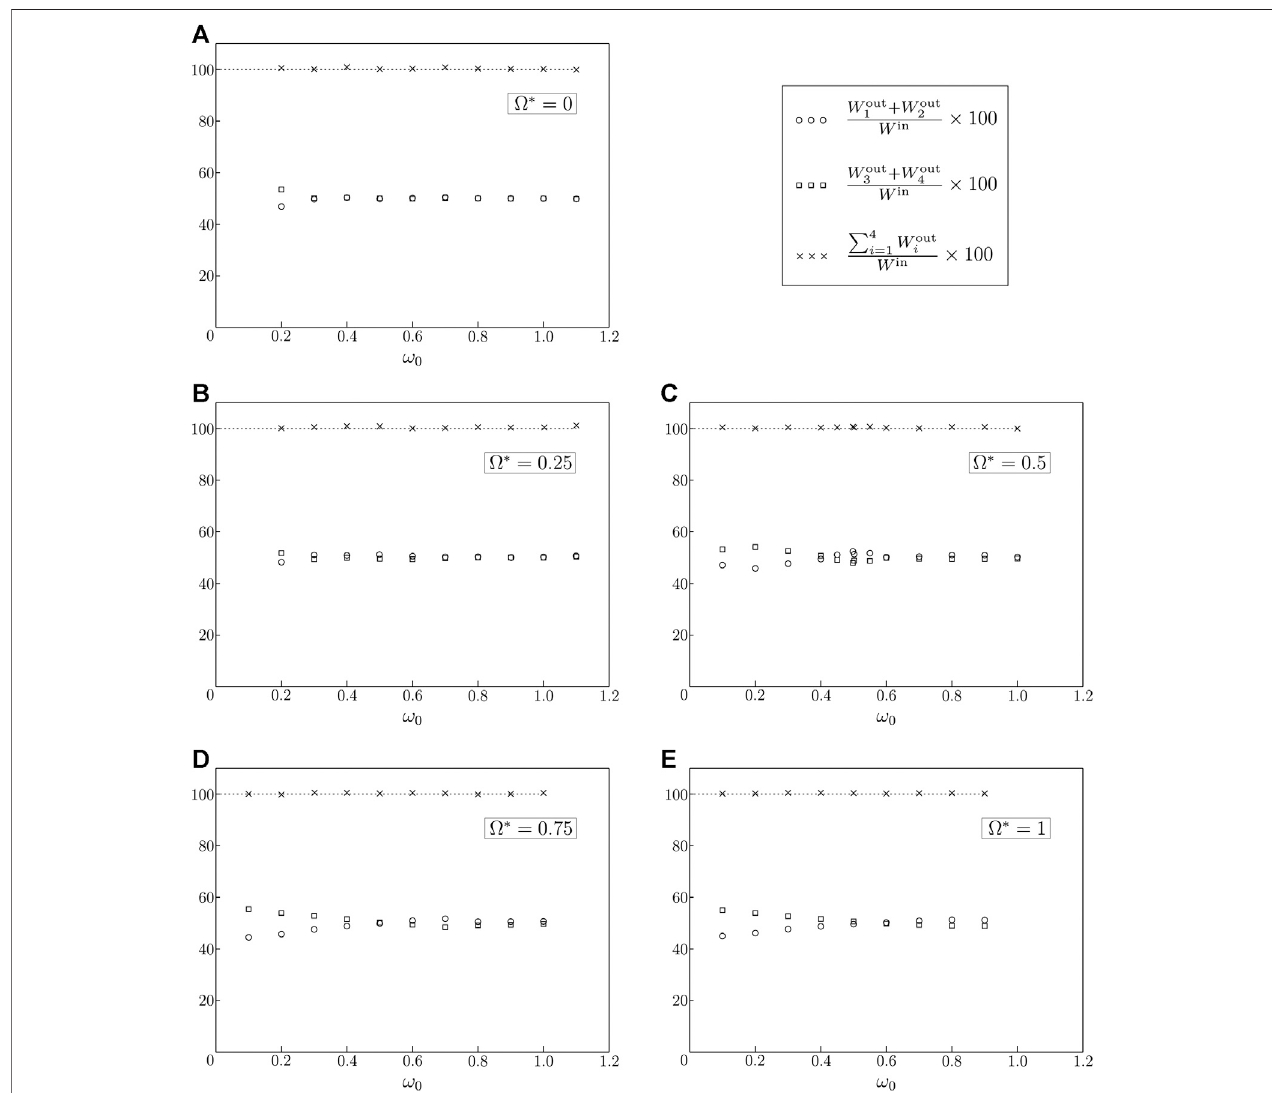
FIGURE 9 | Same as in Figure 8 , but for a vertically-acting point